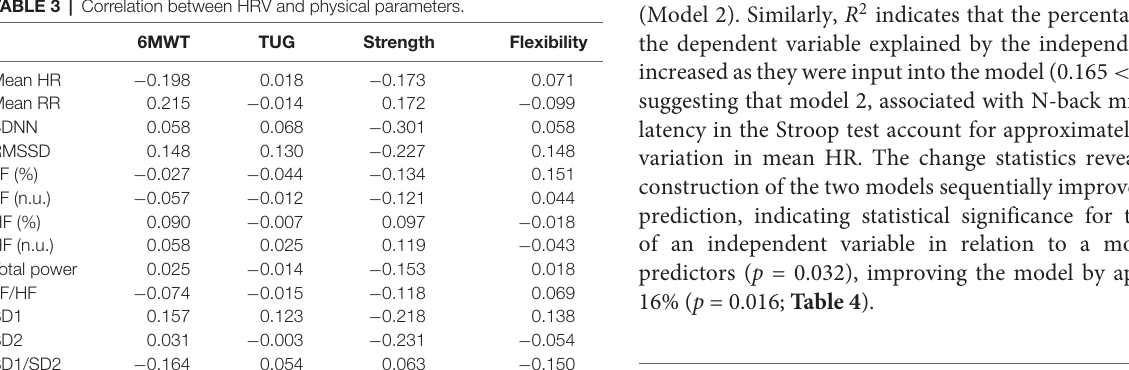
TABLE 4 | Impact analysis, change statistics and analysis of variance for models involving mean HR and